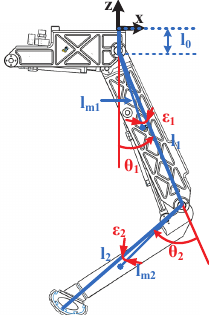
Figure 2. A simplified model of the right front (RF)